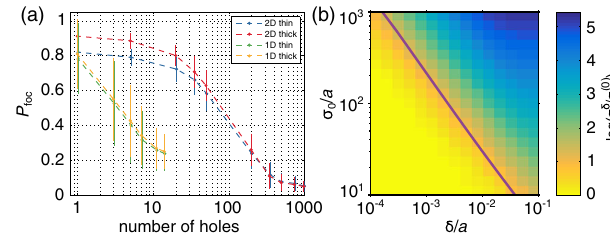
FIG. 7. (a) Integrated probability P to find the focused spin foc wave inside a circle of radius 3 around the set focal point as a function of the number of holes in the lattice. (b) Final width σ δ of f a spin wave in a disordered system compared to the final width σ ð 0 Þ without disorder as a function of the initial width σ 0 and the f disorder strength δ . The results are obtained for a thick lens including corrections up to sixth order (described in Sec. II B), where the potential strength and the focusing time are chosen to 0 Þ minimize σ ð for each value of σ 0 . The line represents f δ ∼ 1 =t , indicating the breakdown of focusing due to disorder foc (details in text).